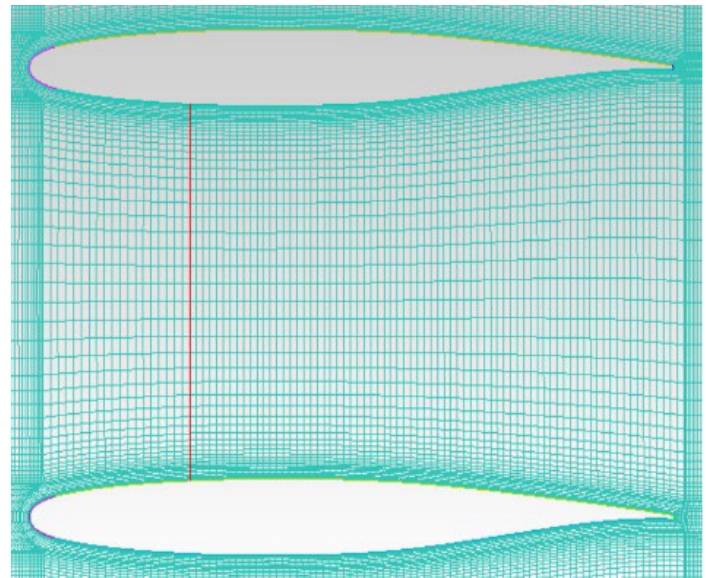
Figure 20. Mesh of the 2D meridian plane.